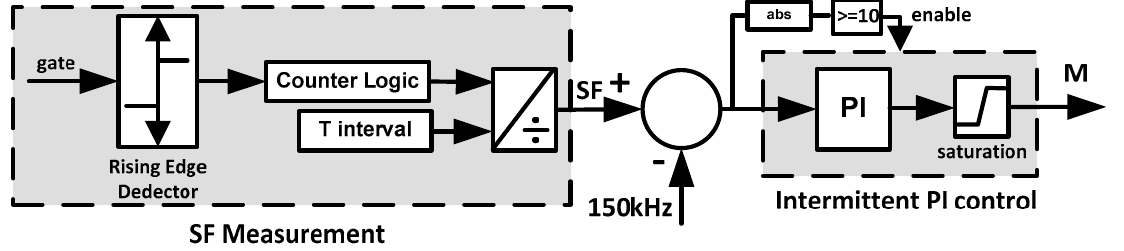
Figure 8. Switching frequency (SF) measurement and intermittent PI controller.